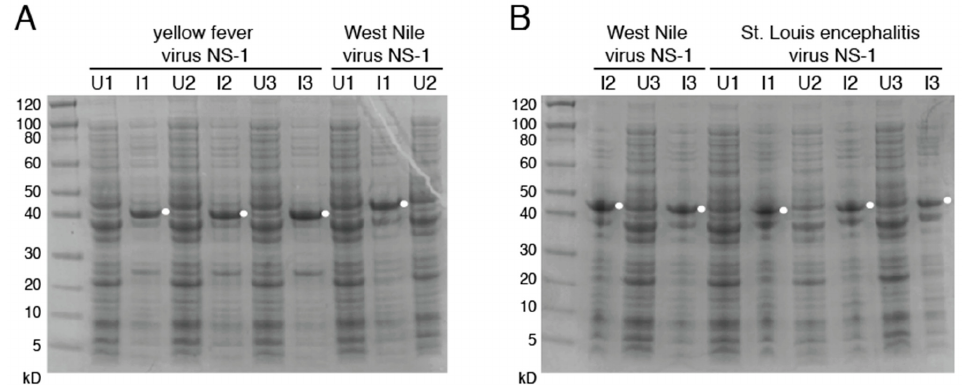
Figure 7. Production of flavivirus NS1. Coomassie-stained SDS-PAGE images of induced (I) and uninduced (U) cultures from NS1 proteins of yellow fever virus ( A ), West Nile virus ( A , B ) and St. Louis Encephalitis virus ( B ). Bands indicate proteins similar to DENV and ZIKV NS1 WT production. Results from three different colonies [1 – 3] for each flavivirus NS1 are indicated. Uncropped gels are displayed in Figure S3.